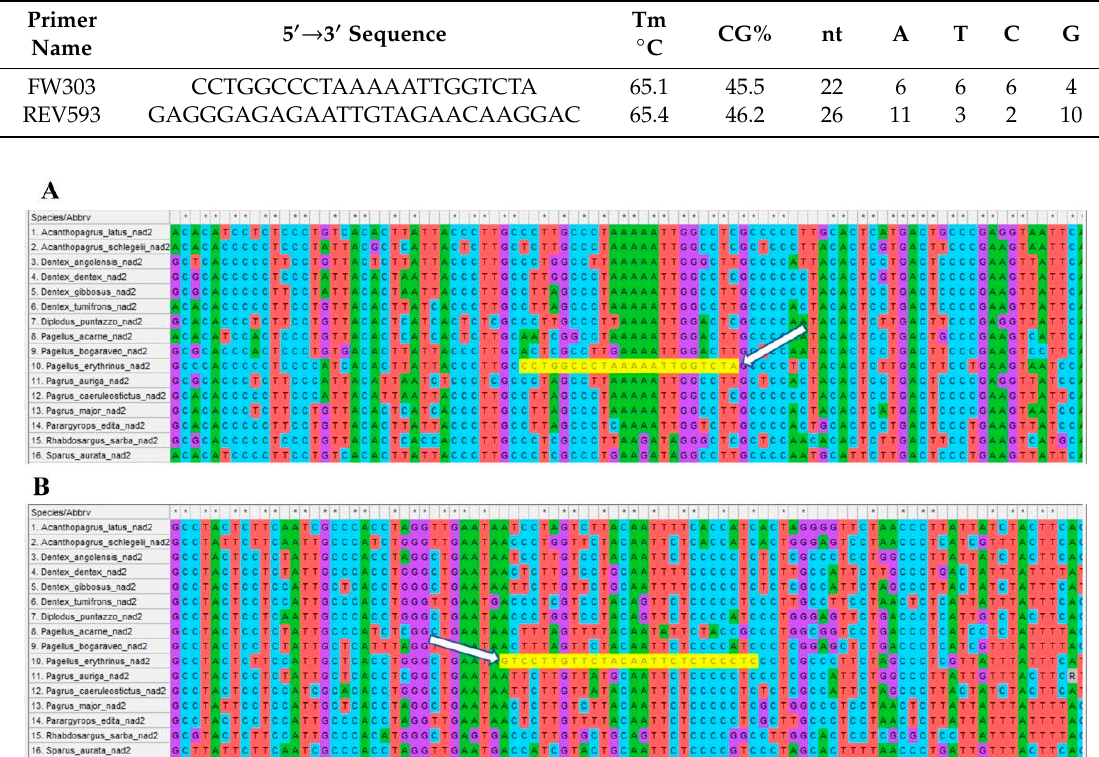
Table 5. P. erythrinus species-specific NAD2 primers.